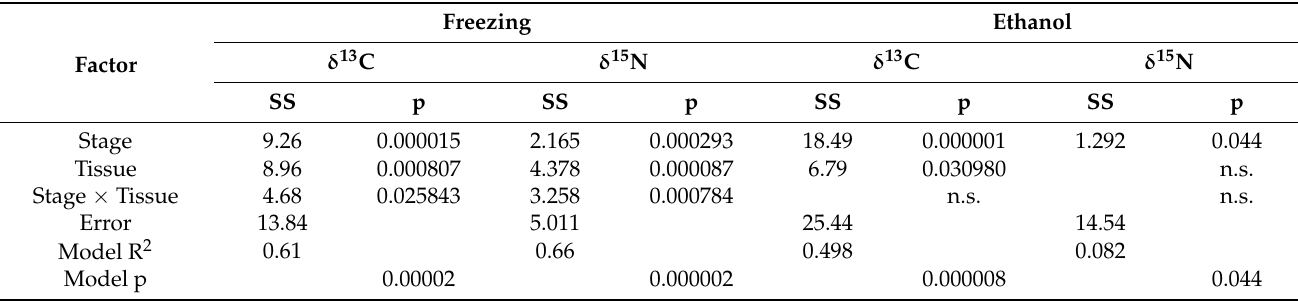
Table 2. Results of δ 13 C and δ 15 N values comparison between the same tissues of B. bufo tadpoles and juveniles using GLM (forward stepwise selection of factors). “n.s.” indicates lack of significant results ( p >